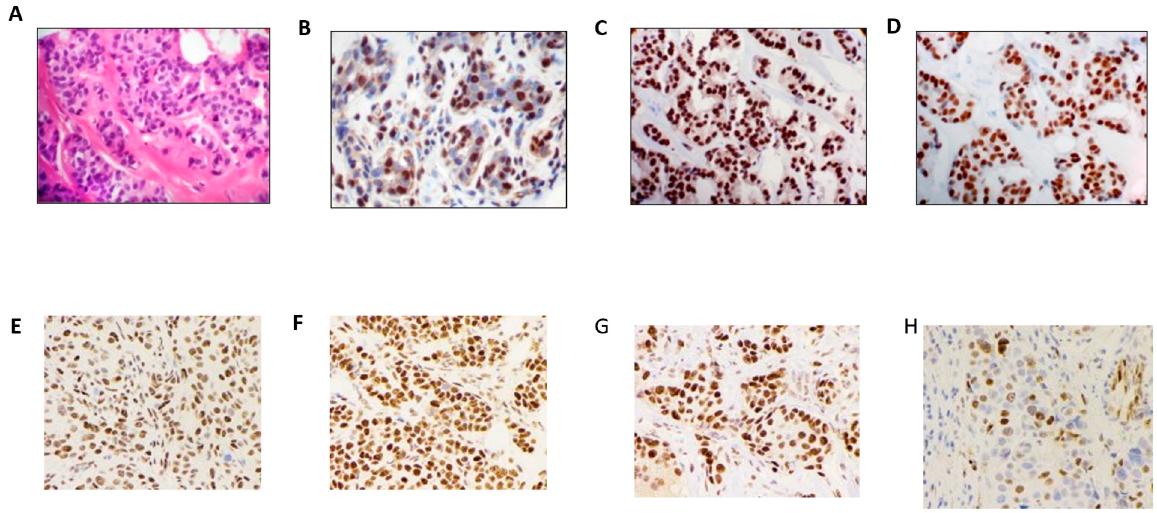
Figure 1. Immunohistochemistry stains of ER β 1 expression and coactivators in infiltrating duct carcinoma: ( A ) H & E staining of infiltrating duct carcinoma; ( B ) Er β 1 expression in the nuclei of benign epithelial cells and myoepithelial cells, stromal cells, and lymphocytes; ( C ) ER β 1 expression in the nuclei of neoplastic epithelial cells of infiltrating carcinoma and stromal cells and lymphocytes (immunohistochemistry staining using polyclonal ER β 1 385p/AR385-10R antibody); ( D ) ER α is expressed only in the nuclei of epithelial cells (original magnification 20 × ); immunohistochemistry stains of ( E ) AIB-1, ( F ) TIF-2, ( G ) SRC-1, and ( H ) p-c-Jun coactivators showing a positive nuclear reaction in the infiltrating carcinoma (original magnification 40×).